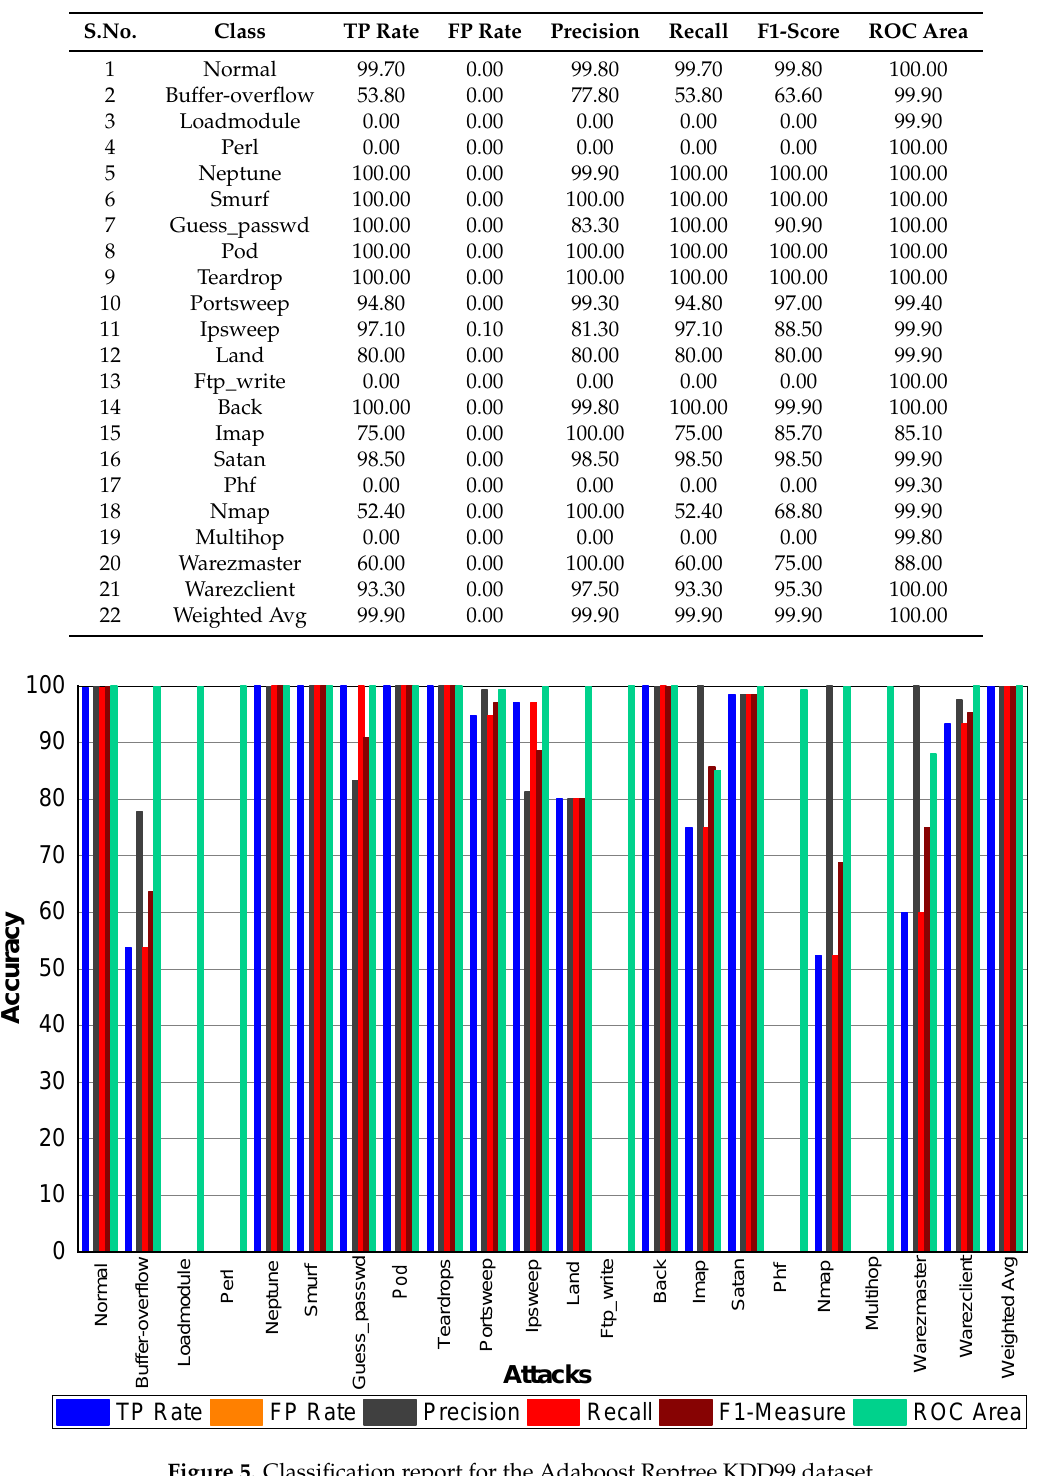
Figure 5. Classification report for the Adaboost Reptree KDD99